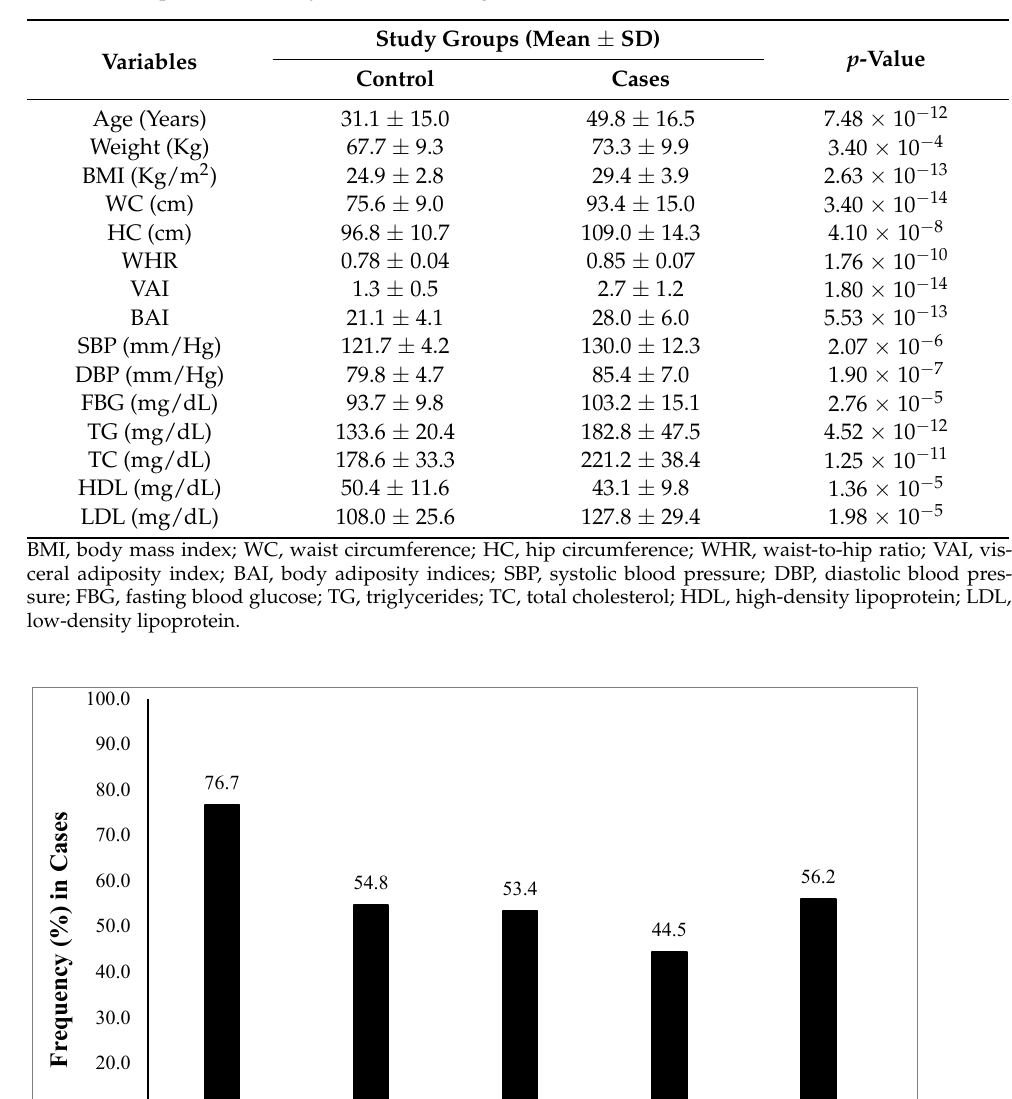
Table 1. Comparison of study variables among cases and controls.